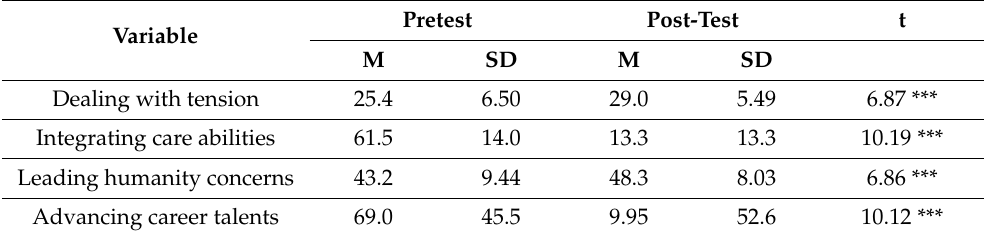
Table 3. Pretest and post-test core nursing values ( N =